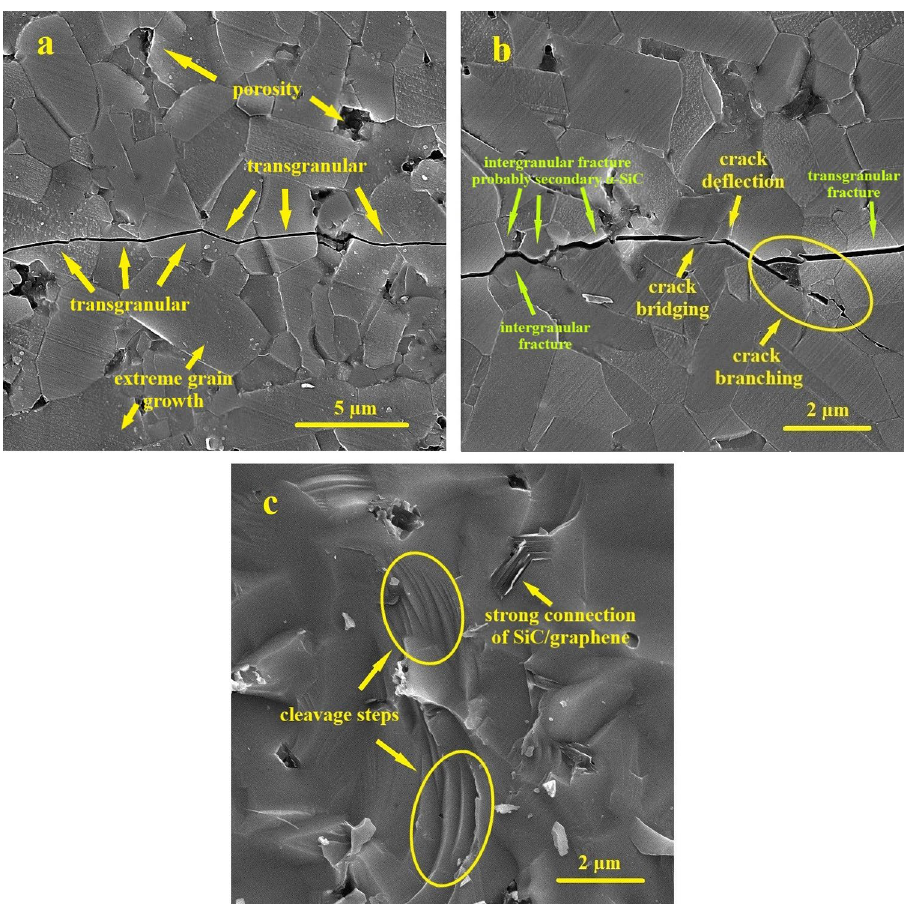
Figure 7. FESEM images of crack microstructure and its growth path in samples ( a ) 1 and ( b ) 5B1G, and ( c ) FESEM image of fracture surface in sample